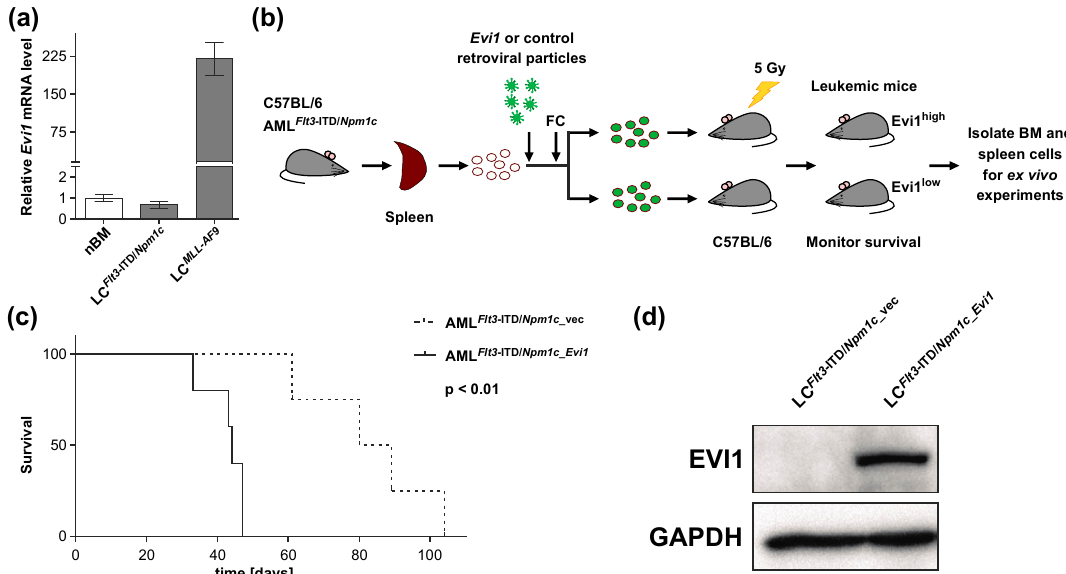
Figure 1. Experimental expression of Evi1 decreases the latency of Flt3 -ITD / Npm1c -driven murine AML. ( a ) Relative Evi1 mRNA levels in normal murine bone marrow cells (nBM) and in leukemic cells from bone marrow (BM) of mice with Flt3 -ITD/ Npm1c - and MLL-AF9 -driven AML (LC Flt3 -ITD/ Npm1c and LC MLL-AF9 , respectively; n = 3). ( b ) Schematic of experimental design. Spleen cells from mice terminally ill with Flt3 -ITD/ Npm1c -driven AML (AML Flt3 -ITD/ Npm1c ) were transduced with pMSCV_FLAG- Evi1 _IRES_GFP or with empty vector as a control. GFP-positive cells were sorted and transplanted into sub-lethally irradiated recipient mice. FC, flow cytometry; BM, bone marrow. ( c ) Kaplan–Meier plot of mice transplanted with Flt3 -ITD/ Npm1c _vec and Flt3 -ITD/ Npm1c _ Evi1 cells (400,000 cells/mouse). n = 4 (AML Flt3 -ITD/ Npm1c _vec group), n = 5 (AML Flt3 -ITD/ Npm1c_Evi1 group). ( d ) Immunoblot analysis of FLAG-EVI1 expression in spleen LC Flt3 -ITD/ Npm1c_Evi1 and LC Flt3 -ITD/ Npm1c _vec from terminally ill recipient mice. GAPDH was used as a loading control.